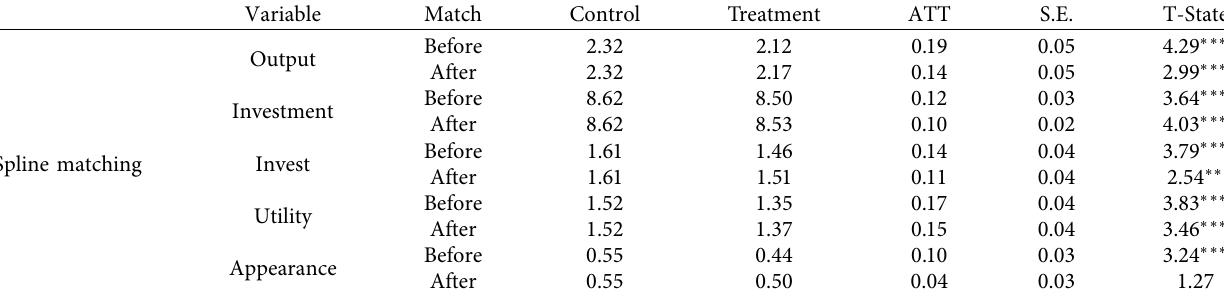
Table 9: Robustness test